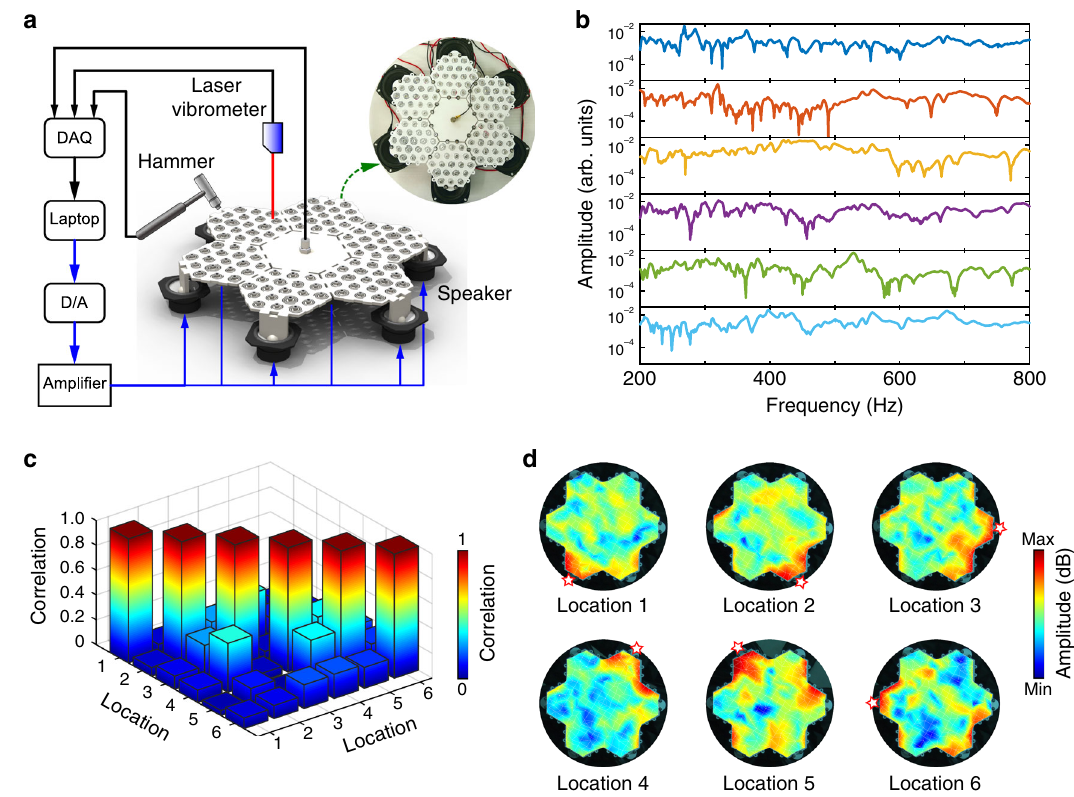
Fig. 3 Spatial vibration encoding property of the metamaterial system. a Experimental setup to test the metamaterial system. b Transmissions when vibrations are excited at six different locations. c Correlation of the transmissions. d Vibration modes of the metamaterial excited at different locations at 695.3